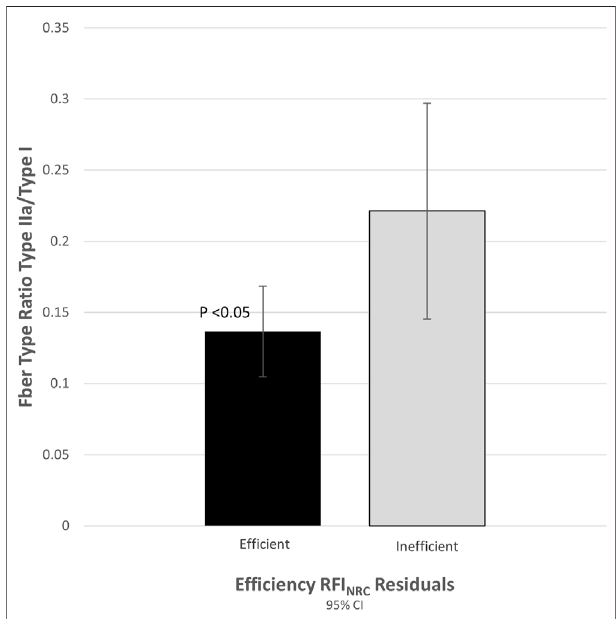
FIGURE 1 | Proportion of fast-to-slow-twitch (type II/type I) fi ber ratio was correlated with expression of actinin-3 ( r = 0.622, p <